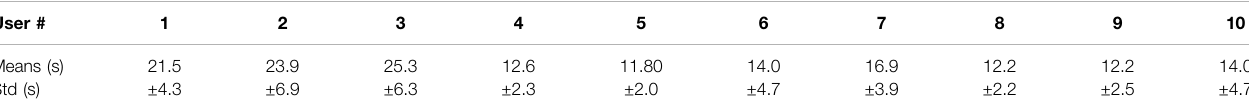
TABLE 1 | Time to complete tasks (mean and ± std).